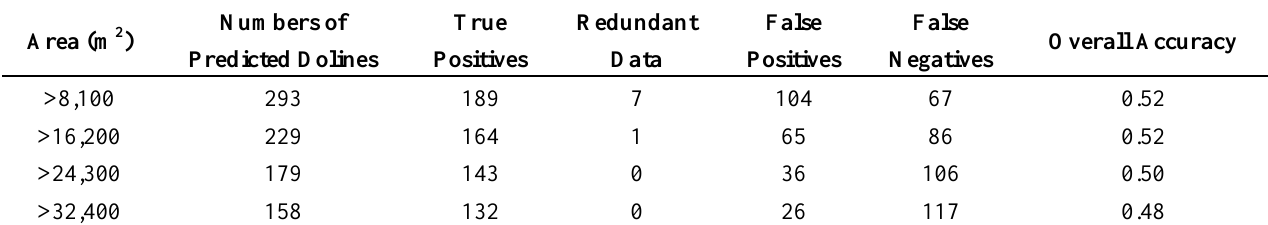
Table 3. Dolines predicted using the area attribute derived from the doline depth > 2 m (SRTM-DEM). Comparison is made with the actual dolines (249) mapped by visual interpretation.